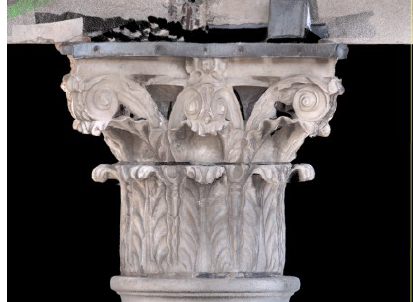
Figure 10: Ortho Image of Corinthian Capital